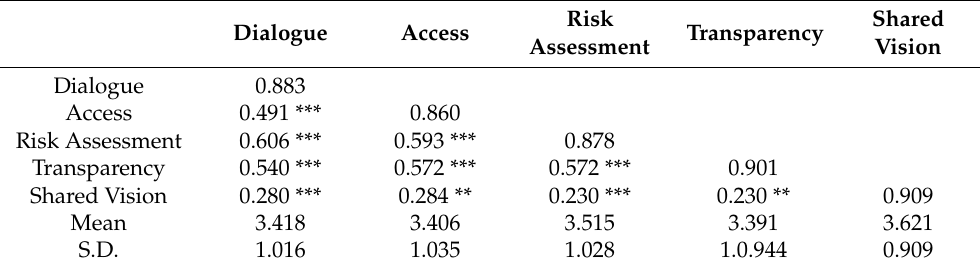
Table 3. Correlation